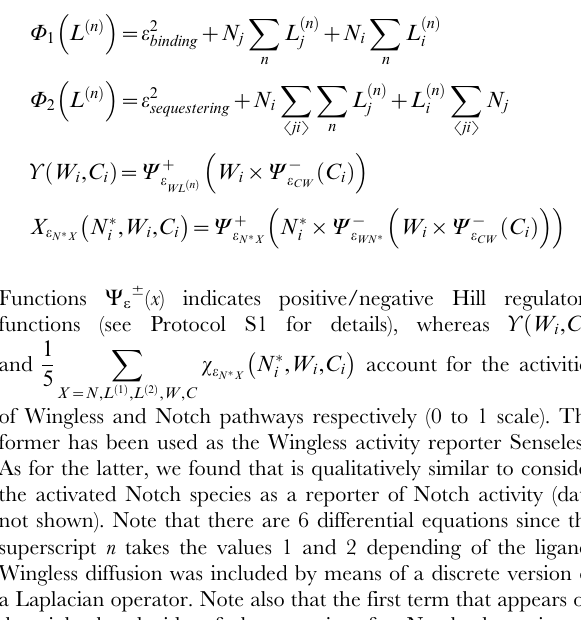
Figure S1 (A) Mature wild-type (A) wing disc showing Delta protein expression (in red) in non-boundary cells. (B) Mature wing disc expressing Wingless (Wg) under dpp Gal4 control and labeled to visualize Delta protein expression (in red). (C) Mature cut 6 mutant wing disc showing Delta protein expression (in red) in boundary cells. (D) Clone of cells lacking cut activity and marked by the absence of GFP (green). Delta protein (in red) starts to be expressed in boundary cells. Figure S2 (A) ‘‘Toy’’ regulatory network: Gene-protein B is positively regulated by gene-protein A. On the other hand, this interaction is negatively regulated by gene-protein C. Hill functions, with a given degree of cooperativity, b , are assumed to effectively model gene-protein regulation. (B) Hill functions for distinct values of cooperativity. As b increases, regulation becomes stiffer and the Hill functions tend towards step functions. Both positive (B top) and negative (B bottom) regulatory functions depend on the concentration of inducer/repressor species x. Figure S3 (A) Evolution of Wg (red) expression levels, Notch activated (black), and Cut (green) in boundary cells as a function of time for the regulatory scheme shown in Figure 6A. The boundary is established and maintained. (C) In silico evolution of the patterns of distinct species. This pattern is in agreement with in vivo results (compare with Figure 3B). The DV boundary is marked by a black arrowhead. Figure S4 Histograms (count, i.e. not normalized) of the parameter values used in the , 1.5 10.4 4 in silico experiments used in the robustness analysis. Units depend on the quantity depicted (see text). The initial condition was also subjected to variation (data not shown). Found at: doi:10.1371/journal.pone.0000602.s004 (0.82 MB